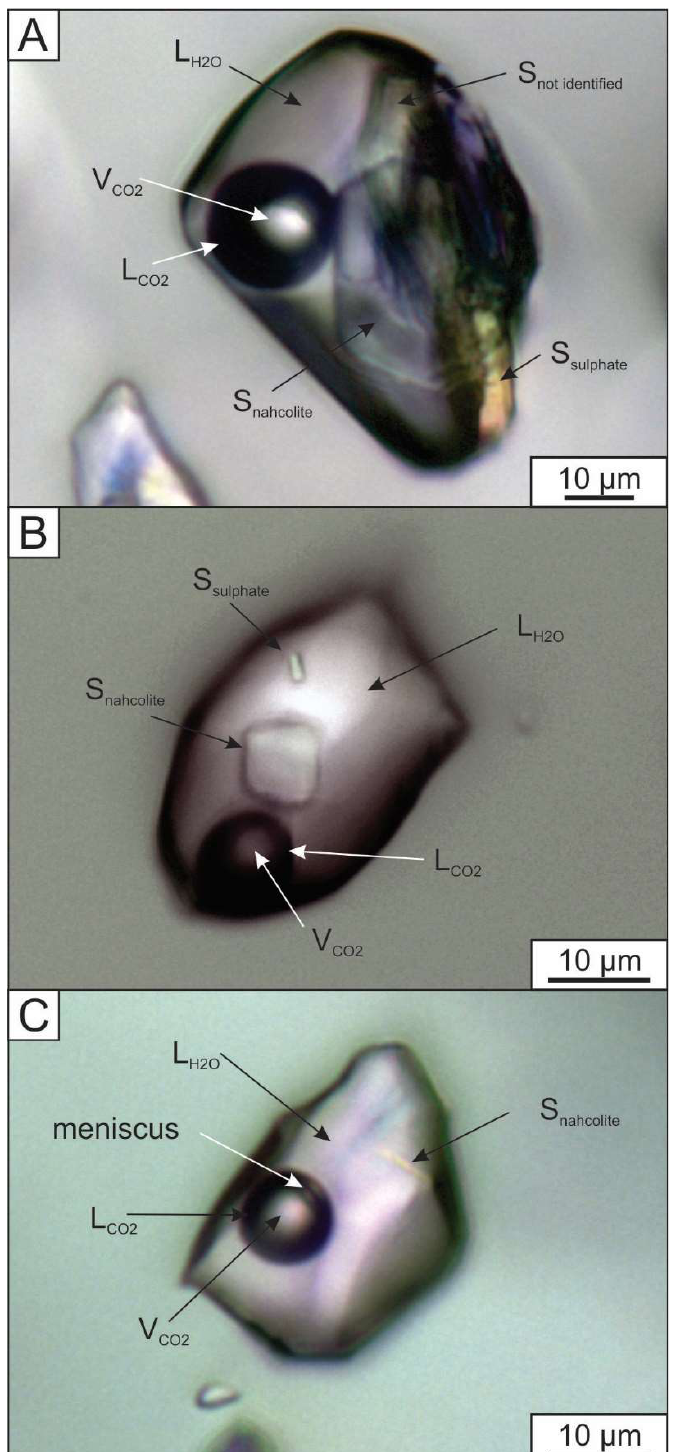
Figure 10. Representative fluid inclusions in quartz crystals of the breccia of Berglia-Glassberget. ( A ) Aqueous Type I inclusion containing a CO 2 bubble and several large solids including nahcolite and a sulphate, ( B ) Aqueous Type II inclusion with a CO 2 bubble and two solids, nahcolite and a sulphate, ( C ) Aqueous Type III inclusion with a CO 2 bubble and a nahcolite crystal. L—liquid phase, V—volatile phase,